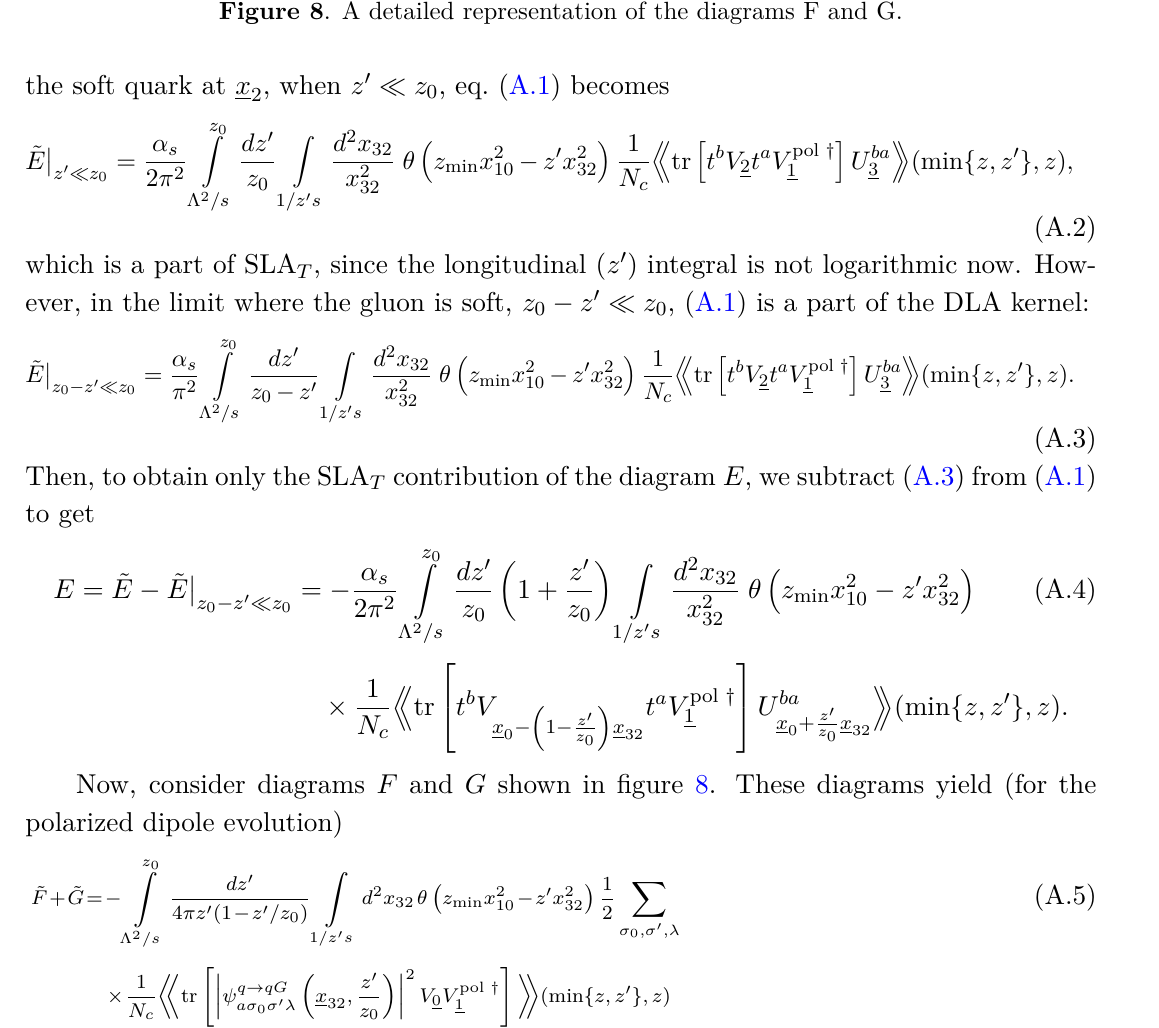
Figure 8 . A detailed representation of the diagrams F and